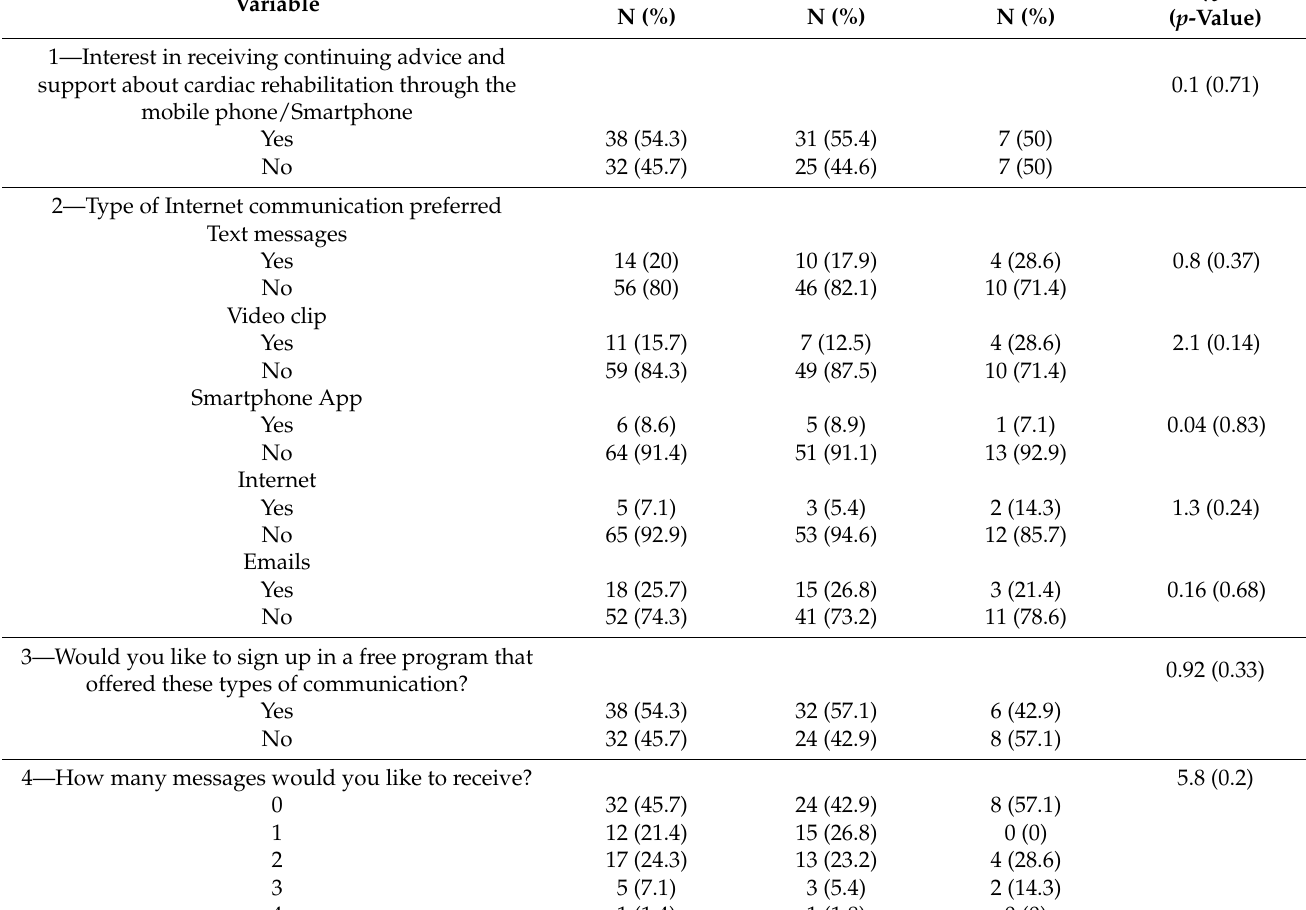
Table 3. Preferences of older adults towards technology-based cardiac physical therapy